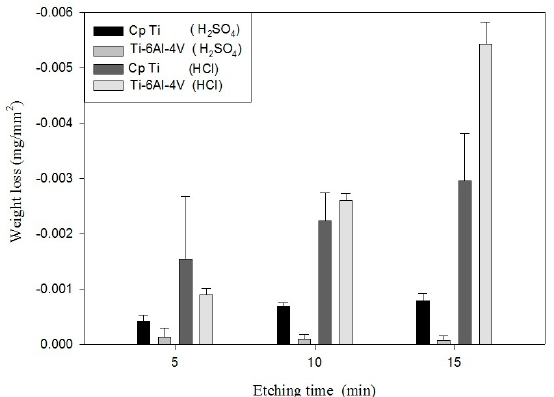
− 0.162 Table 5. The etching rates of CP Ti for different etchant solutions at RT or BT.